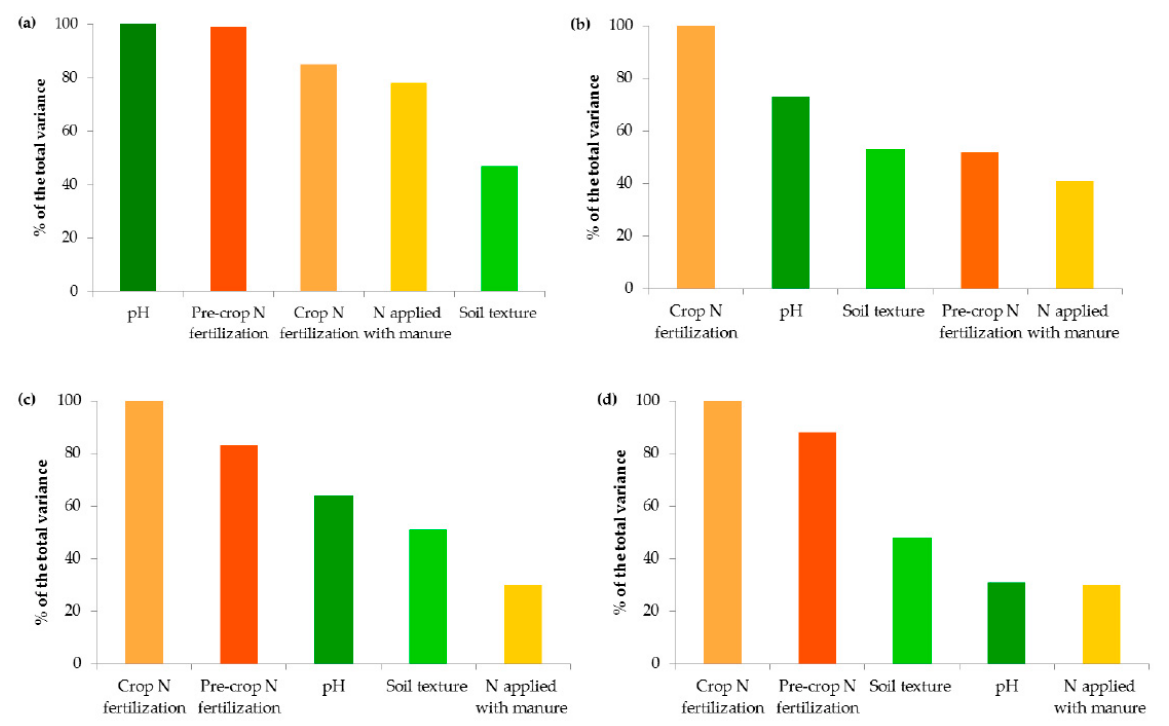
Figure 8. Variables in terms of their importance on the contents of organic carbon ( a ), ammonium nitrogen ( b ), nitrate nitrogen ( c ) and mineral nitrogen ( d ). The same letter means not significantly different.